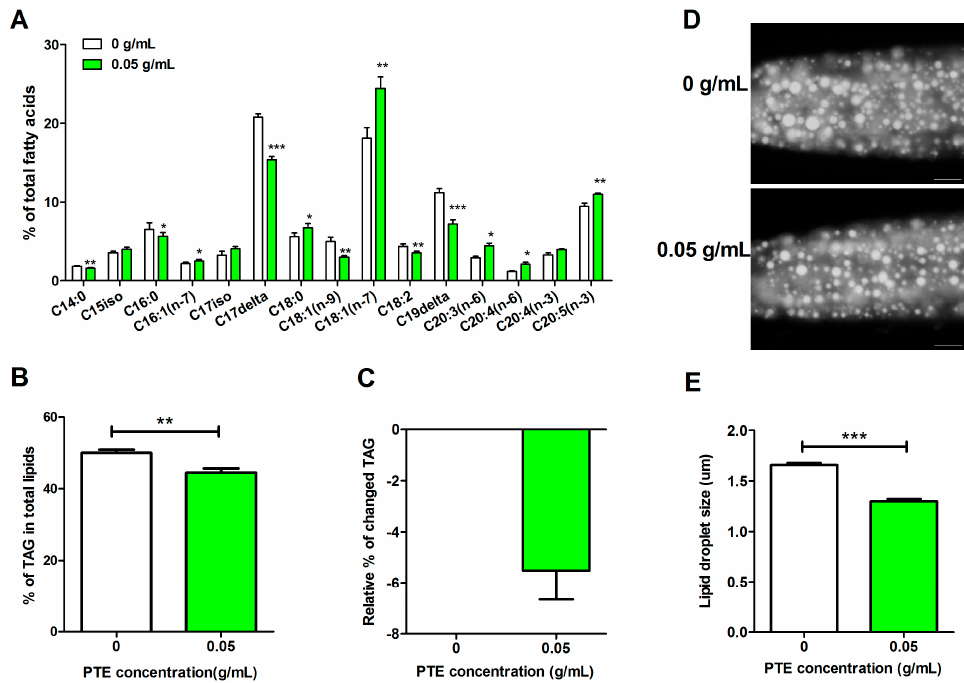
Figure 1. PTE reduced fat storage and modified the level of fatty acids compositions. ( A ) the level of fatty acids determined by thin-layer chromatography and gas chromatography (TLC/GC); ( B ) percentage of triacylglycerols (TAG) in total lipids (TAG + PL, phospholipids); ( C ) relative percentage of changed TAG; ( D ) Nile Red staining of fixed late L4 worms. Exposure time: 25 ms. Scale bar represents 20 μ m. Data are presented as mean ± SEM of four biological independent repeats; and ( E ) quantification of lipid droplet size. Data are presented as ± SEM of 10 worms. Significant differences between PTE treated group (0.05 g/mL) and the control group (0 g/mL), *** p < 0.001, ** p < 0.01, * p < 0.05. Table 1. Genes that showed differencially expression treated by different concentrations of PTE.